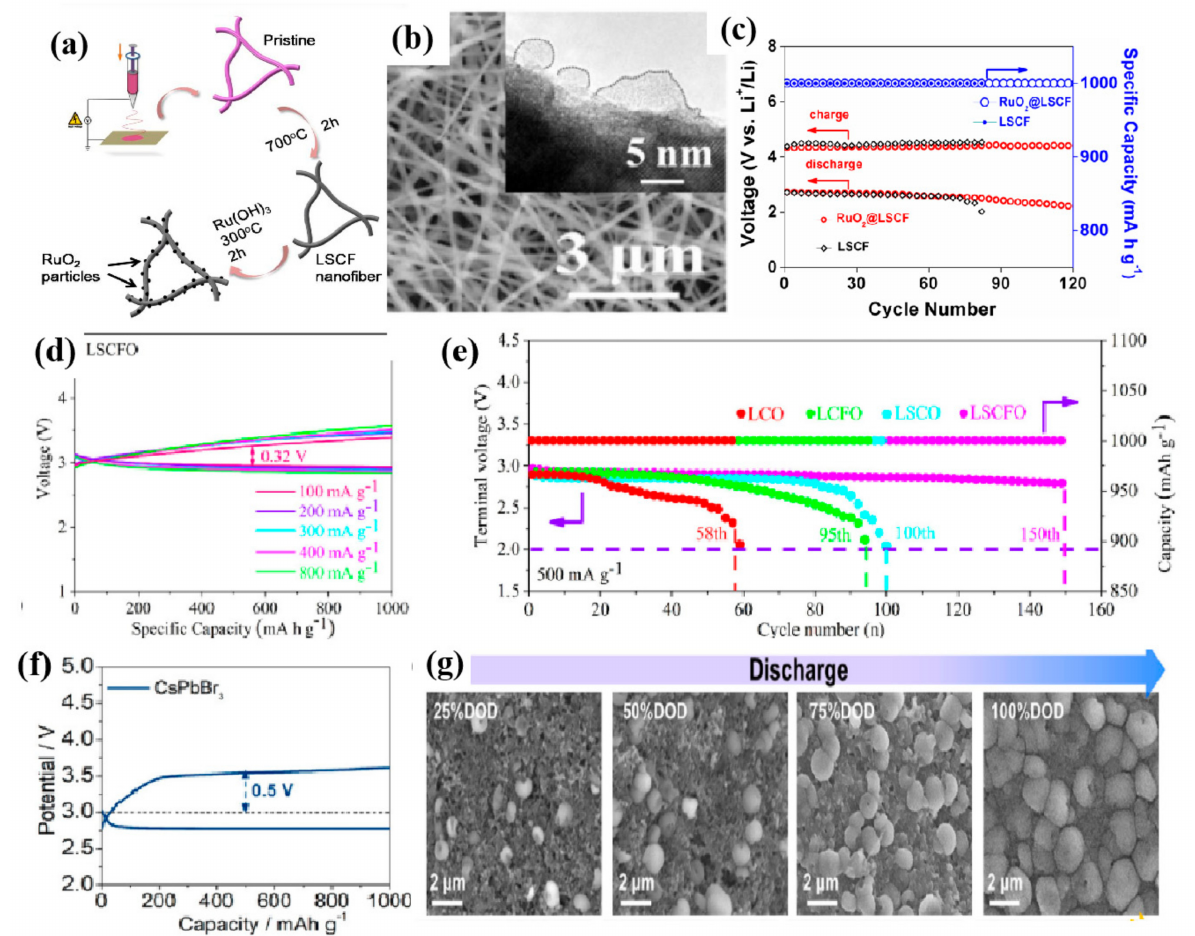
Figure 12. ( a , b ) Schematic diagram and SEM/TEM image of simple synthesis of RuO 2 nanoparticles@LSCF-NFs. ( c ) Battery discharge/charging terminal voltage RuO 2 @LSCF -NFS and LSCF-NFs catalysts with a cut-off capacity of 1000 mAhg − 1 at 100 mAg − 1 . Reprinted with permission from ref. [195]. Copyright 2017 John Wiley and Sons. ( d ) Magnification performance of LABs based on LSCFO electrode. ( e ) Cycle performance of LABs at 500 mA g − 1 current density and capacity of 1000 mA h g − 1 . Reprinted with permission from ref. [200]. Copyright 2021 American Chemical Society. ( f ) Discharge and charging curves of CsPbBr 3 cathode with capacity limited to 1000 mA h g − 1 and current density of 0.1 A g − 1 . ( g ) Morphological evolution of CsPbBr 3 cathode during discharge. Reprinted with permission from ref. [201]. Copyright 2021 American Chemical